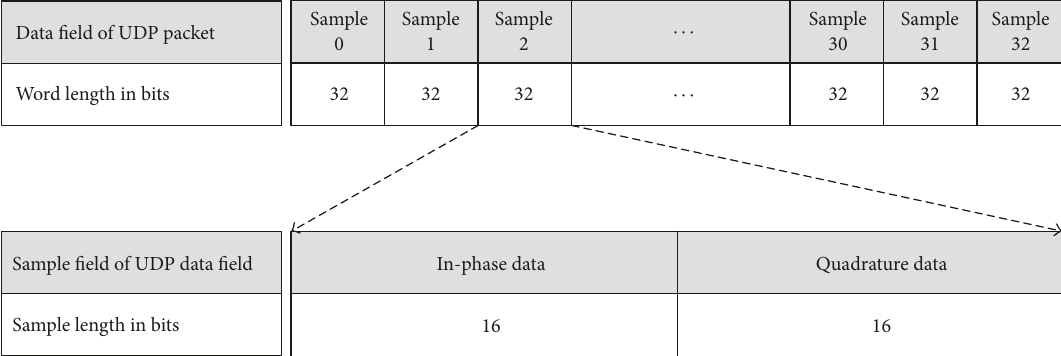
Figure 27: UDP frame data field format. Data field is composed of 33 samples collected from a DDC core output.